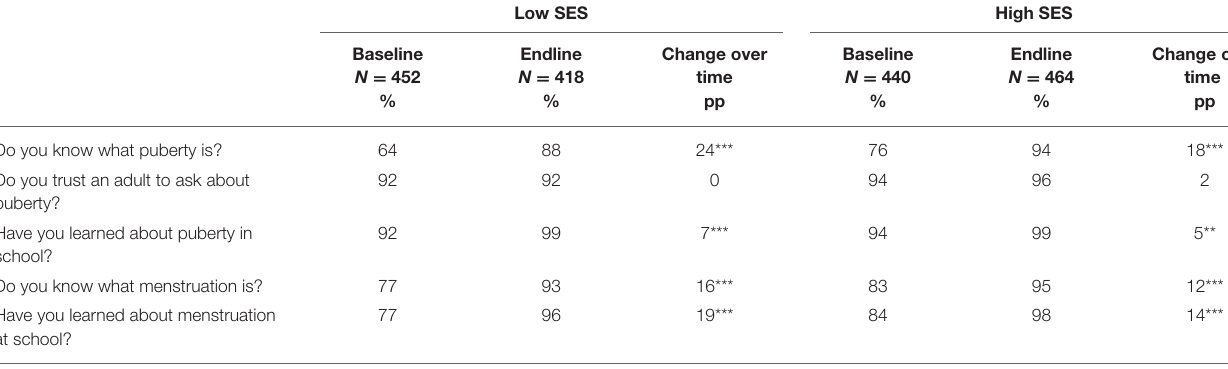
TABLE 8 | Change in MHH knowledge by socioeconomic status among all female WSE survey respondents.